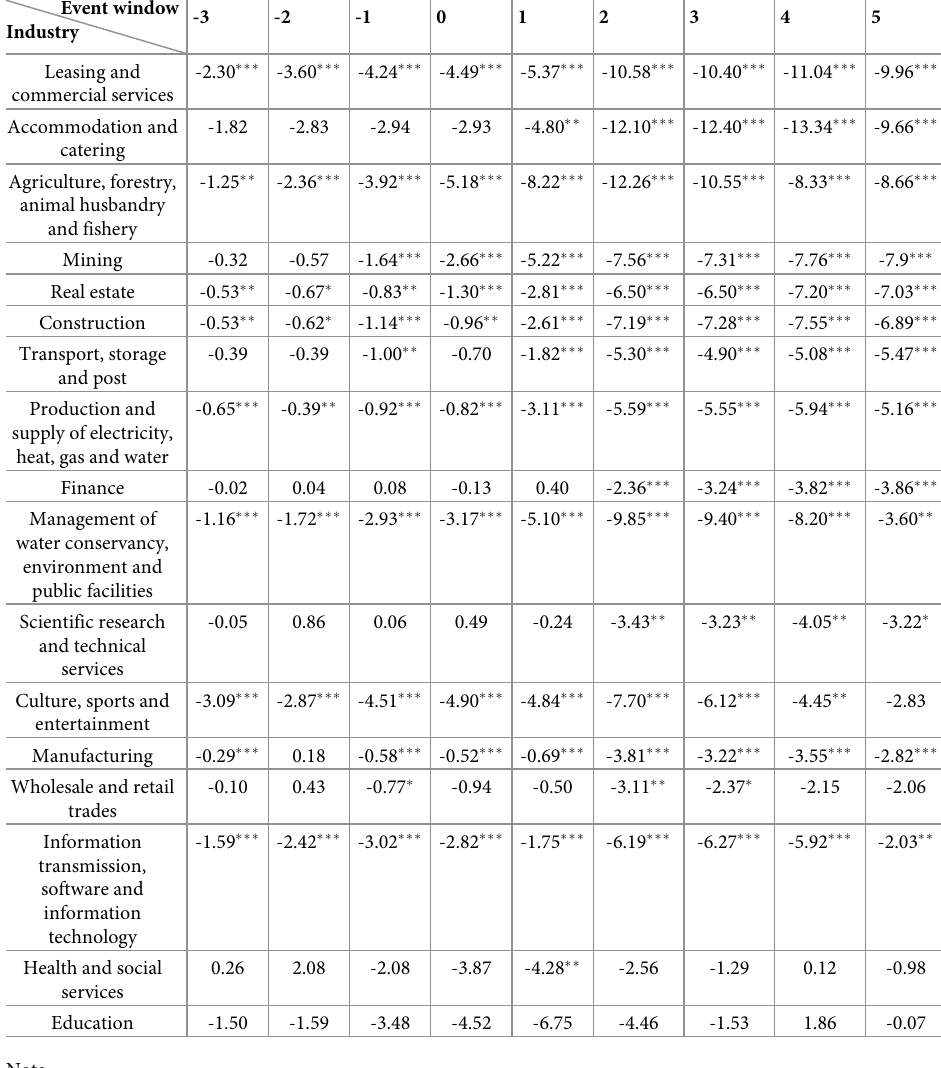
CAARs over the 9-day event window under the ICNEA scheme. We see negative pandemic shock for most of the industries, of which, the 5 worst affected industries were “wood process- ing and manufacture of wood, bamboo, rattan, palm, and straw-made articles”, “catering”,